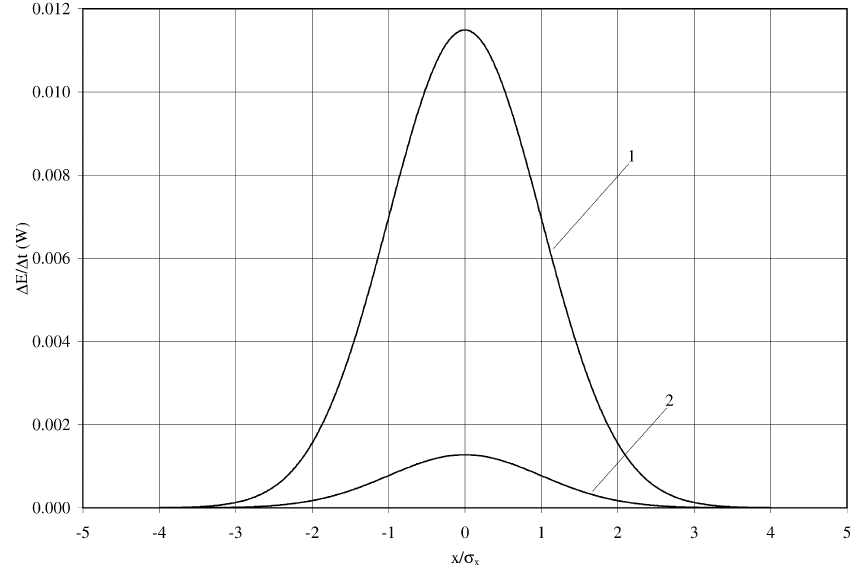
FIG. 2. Heat power from bunch scattering on wire, I (cid:1) 0.9 mA, d 1 (cid:1) 30 m m, d 2 (cid:1) 10 m m.